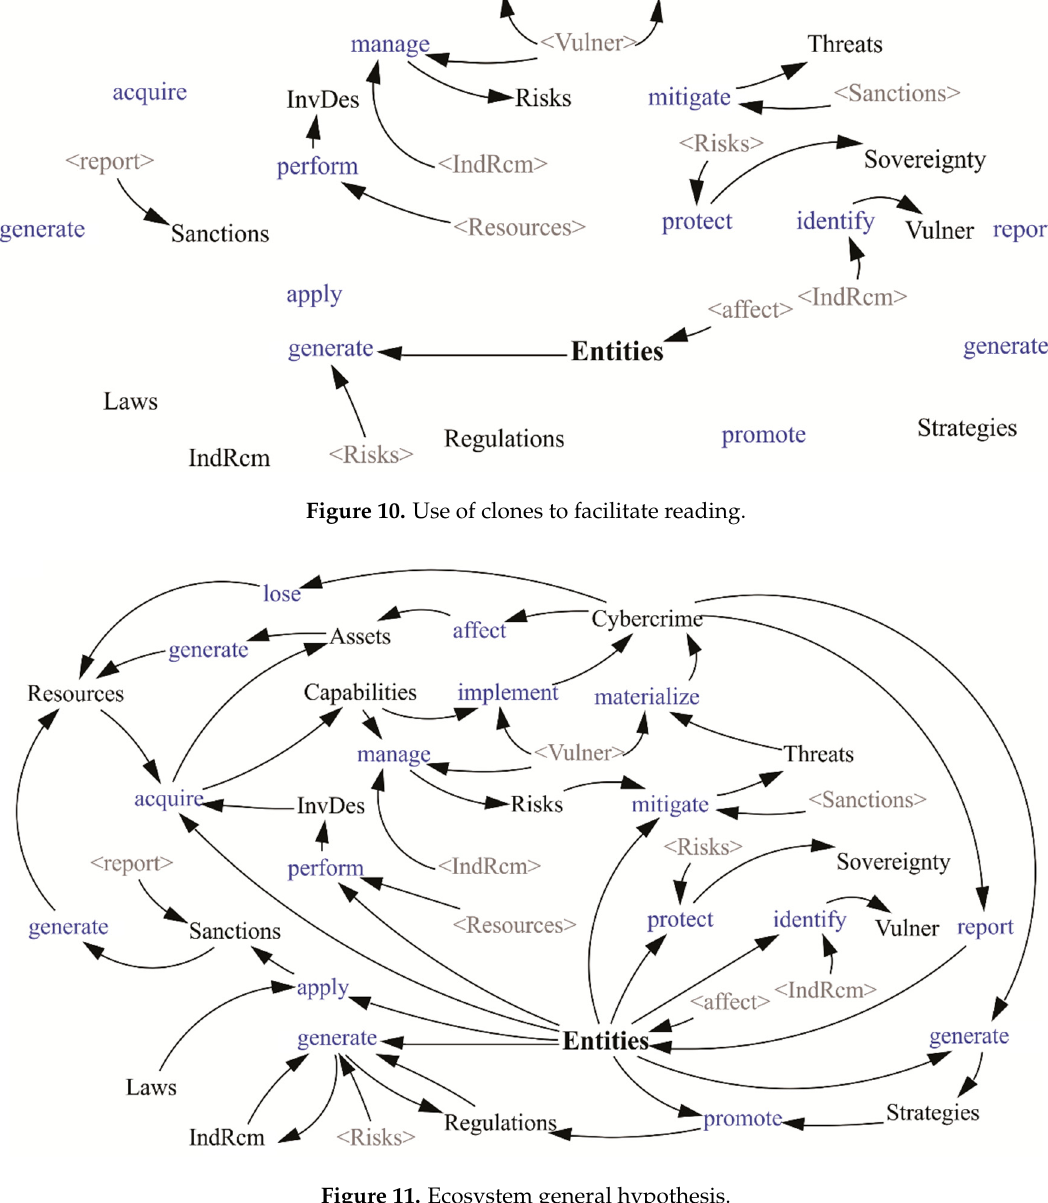
Figure 11. Ecosystem general hypothesis.